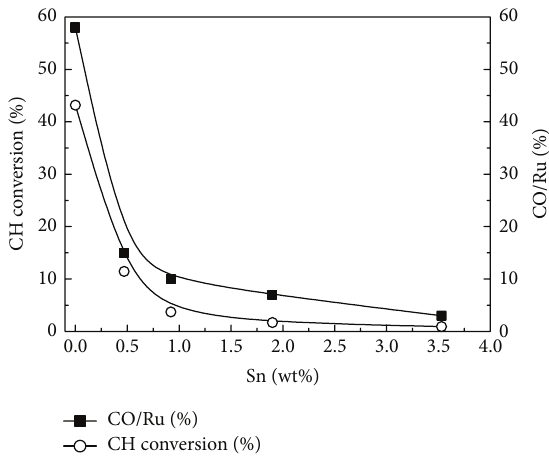
Figure 2: Influence of the Sn content of the catalysts on the conversion of cyclohexane and the CO chemisorption capacity.